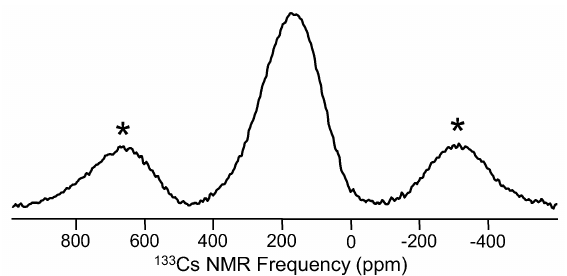
Figure 13. 133 Cs MAS NMR spectrum of a glass having a composition of 25Cs 2 O-37.5Al 2 O 3 -37.5Ga 2 O 3 [87]. Spinning sidebands are marked by asterisks. Data were collected at 11.7 T using a 2.5-mm MAS NMR probe (sample volume = 11 µ L; spinning rate = 30 kHz), with a total acquisition time of 1–2 h.